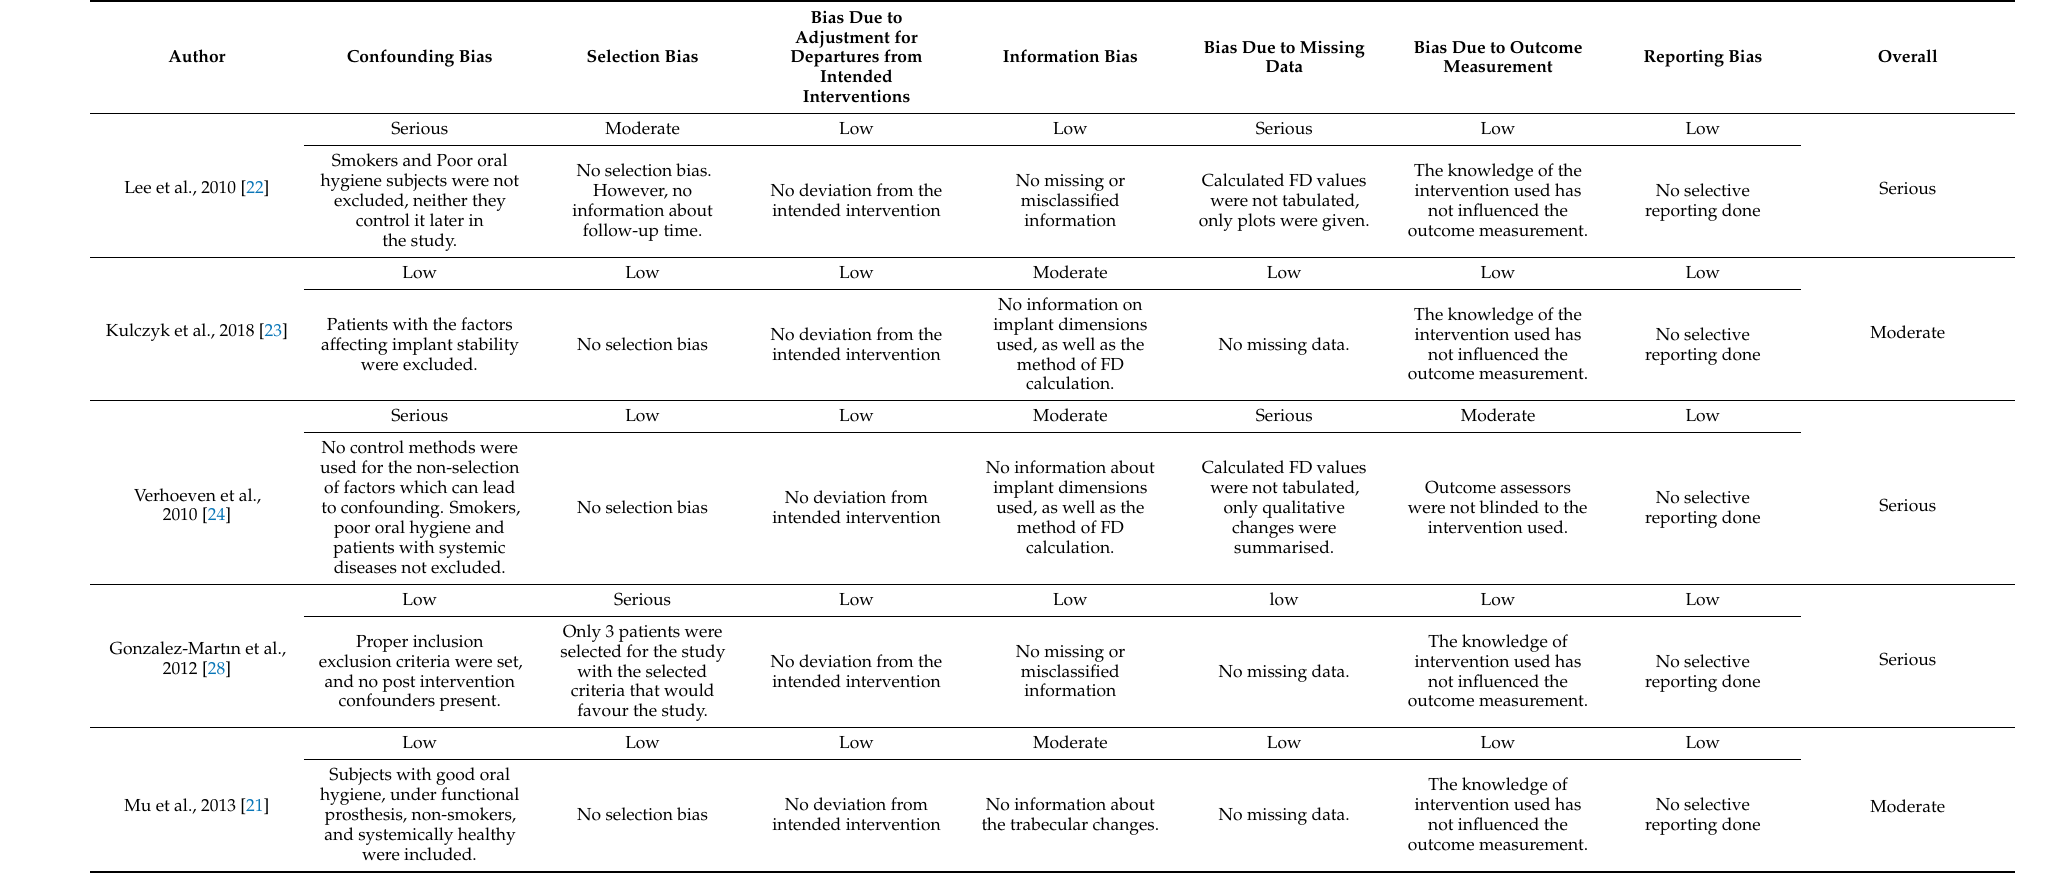
Table 4. The result outcomes of Risk of Bias of non-randomized studies of the